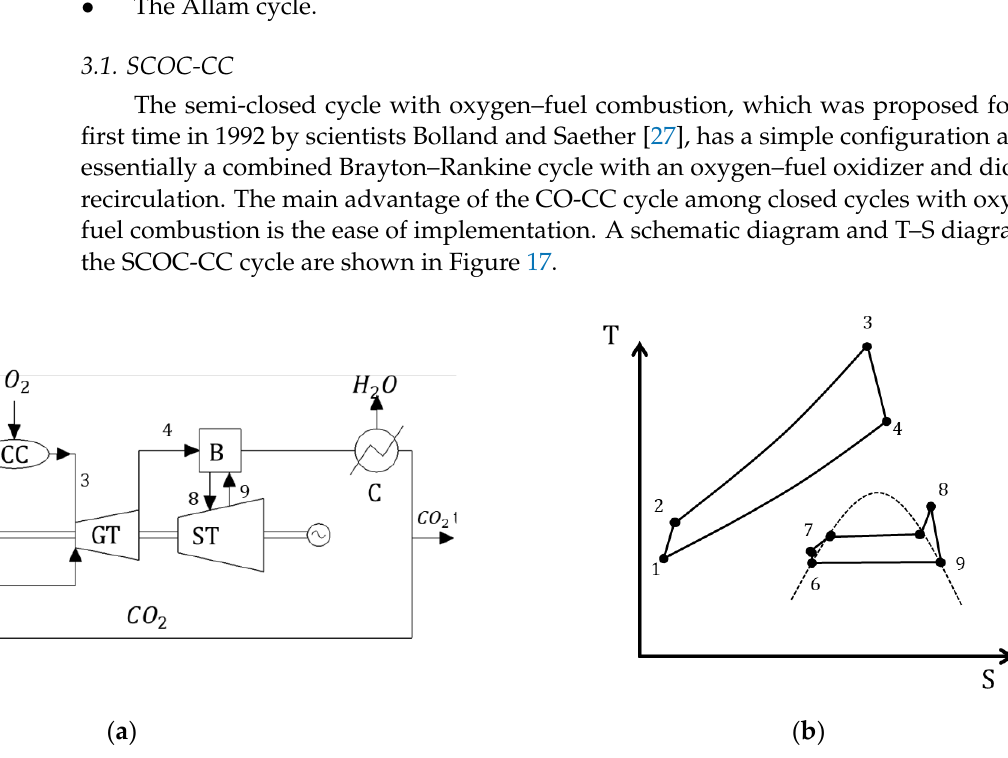
Figure 17. SCOC-CC: ( a ) schematic diagram; ( b ) T – S diagram [27]. Comp. — compressor; CC — com- Figure 17. SCOC-CC:( a )schematicdiagram; ( b )T–Sdiagram[27]. Comp.—compressor; CC—combustion bustion chamber; GT — gas turbine; B — boiler; ST — steam turbine; C — cooler – separator. chamber; GT—gas turbine; B—boiler; ST—steam turbine;